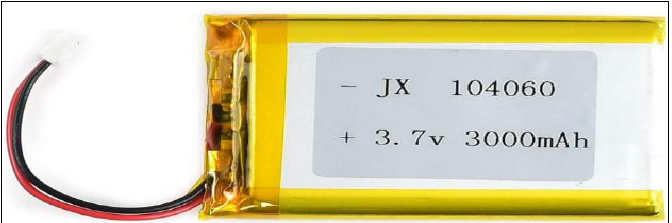
Figure 12: Lithium polymer battery. Source: Taken from [38].